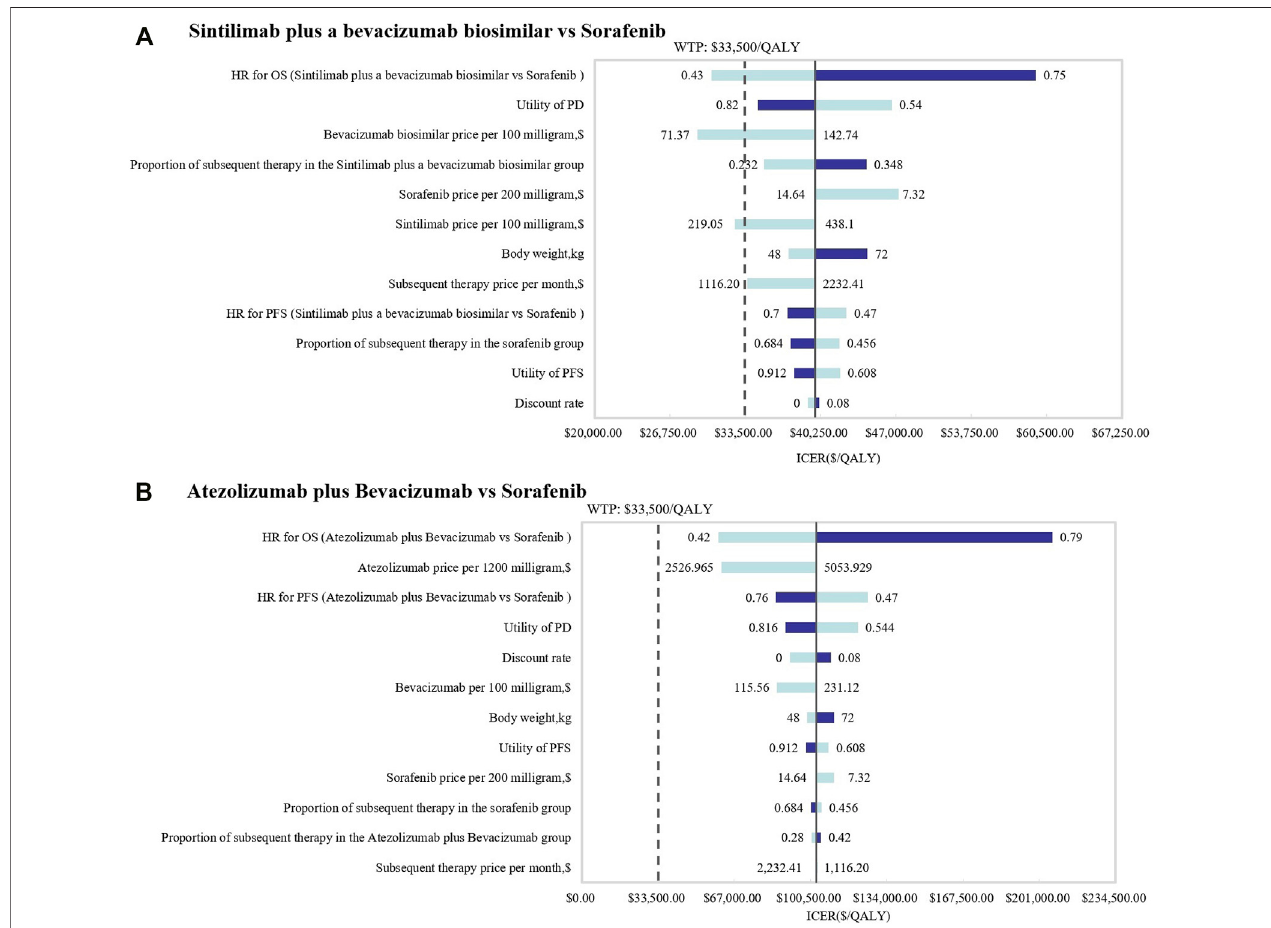
FIGURE 2 | Tornado diagrams of one-way deterministic sensitivity analyses. One-way deterministic sensitivity analyses of (A) SB and (B) AB in comparison with sorafenib.